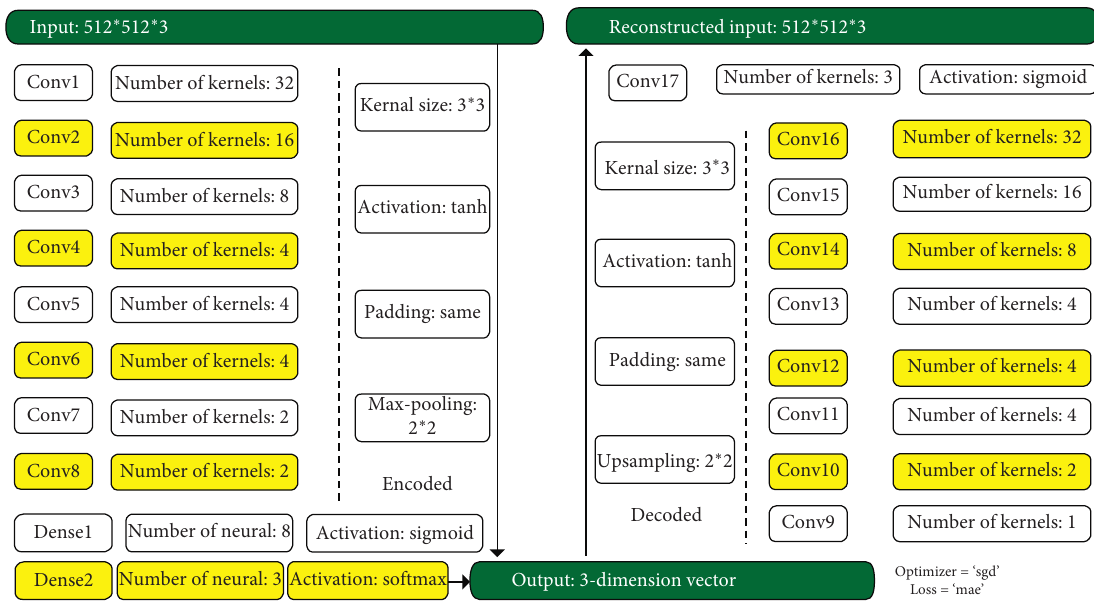
Figure 3: Parameters of the proposed stacked convolutional autoencoder. There is a fully connected layer with eight neurons and a softmax classifier with three neurons added at the end of the encoder. For the eight convolution layers in the encoder and the convolution layers from 9 to 16 in the decoder, kernel size, activation function, padding, and max-pooling are the same, only the number of kernels is changing, shown in the encoded and decoded part, respectively. For the convolutional layer 17, the number of kernels is 3, and the activation function is sigmoid.